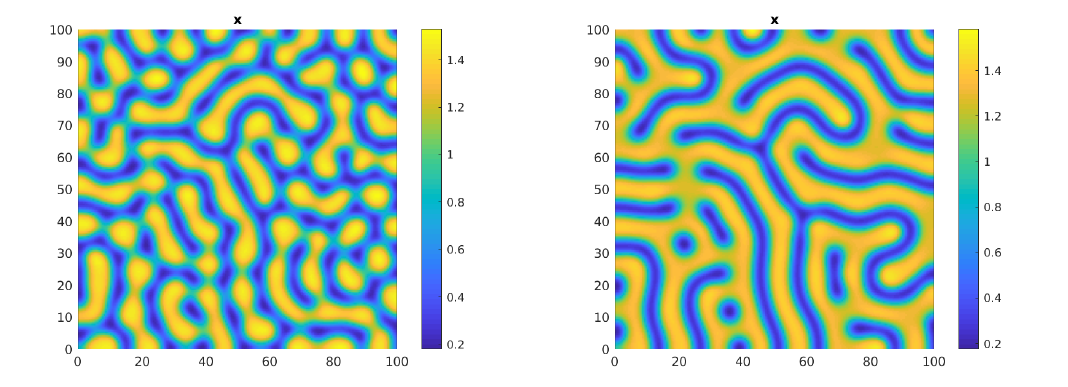
Figure 12. Plots of the solution x of system (2)–(5) in the parameter setting of Example 3 for T = 500, T = 1000. Here γ 21 = 0.35.